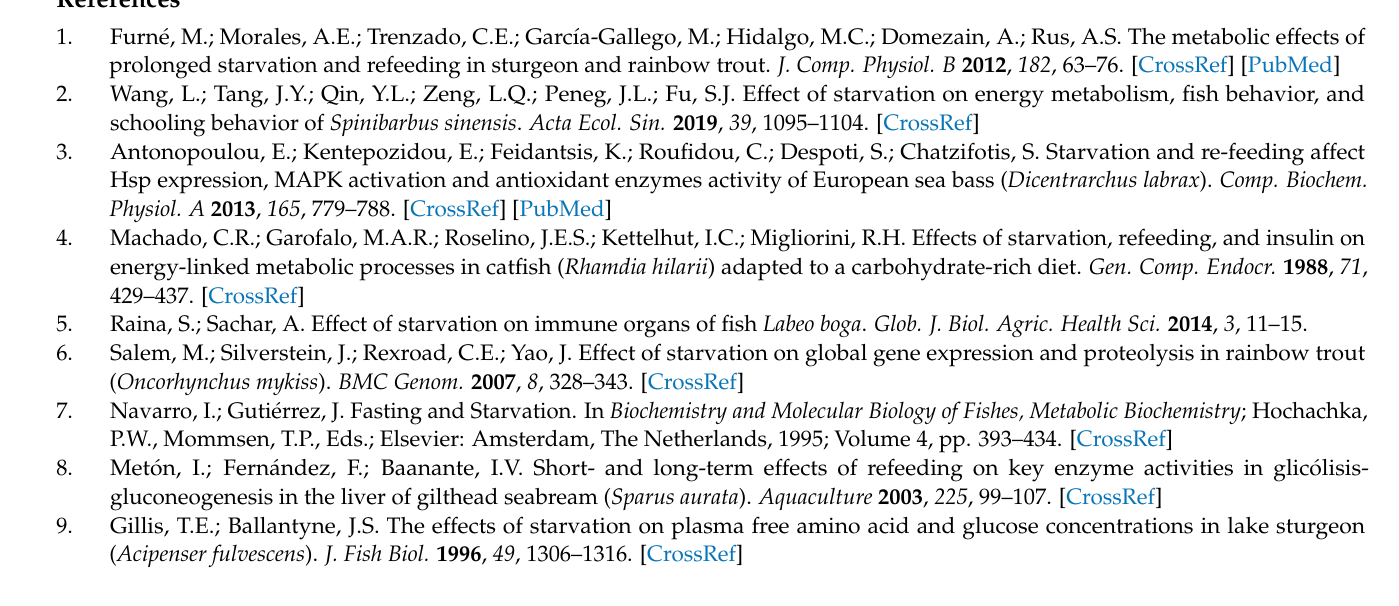
Figure S3: KEGG pathway showed that significantly upregulated and downregulated genes partici- pate in N-glycan biosynthesis in the liver transcriptome of yellowcheek starved for 8 (A) and 28 (B) days compared with the control; Figure S4: KEGG pathway showed that significantly upregulated and downregulated genes participate in fatty acid elongation in mitochondria (4 < n < 16) in the liver transcriptome of yellowcheek starved for 8 (A) and 28 (B) days compared with the control; Figure S5: KEGG pathway showed that significantly upregulated and downregulated genes partici- pate in general forms of fatty acid elongation in mitochondria (4 < n < 16) in the liver transcriptome of yellowcheek starved for 8 (A) and 28 (B) days compared with the control; Figure S6: KEGG pathway showed that significantly upregulated and downregulated genes participate in fatty acid elongation in endoplasmic reticulum (n ≥ 16) in the liver transcriptome of yellowcheek starved for 8 (A) and 28 (B) days compared with the control; Figure S7: KEGG pathway showed significantly upregulated and downregulated genes participate in steroid biosynthesis in the liver transcriptome of yellowcheek starved for 8 (A) and 28 (B) days compared with the control; Table S1: Basic information of sequencing